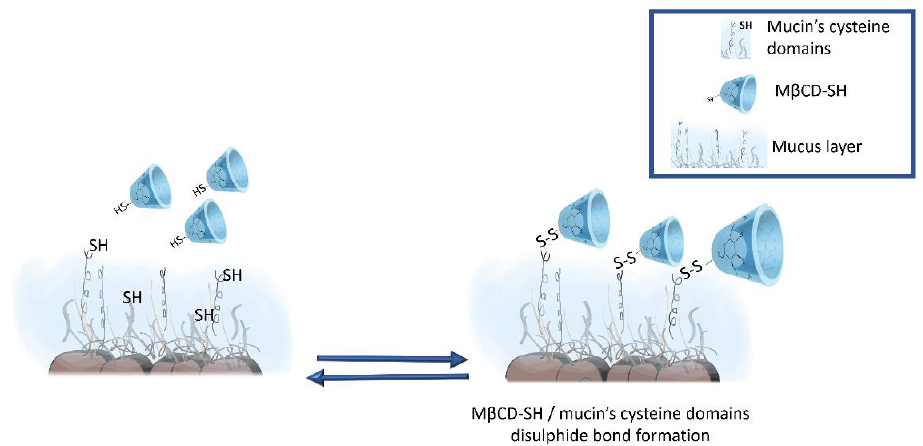
Figure 4. Mucoadhesion: representation of the molecular interaction mechanism of M β CD-SH Figure 4. Mucoadh esion: representation of the molecular interaction mechanism of MβCD -SH de- derivative and mucins. rivative and mucins.